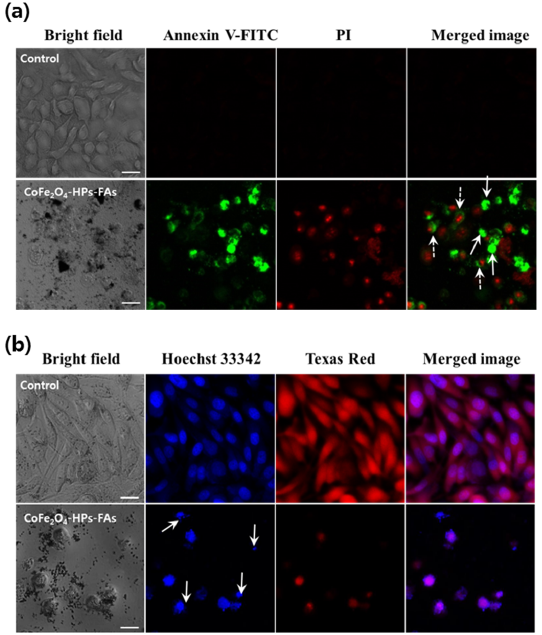
Figure 6. Confocal fluorescence images for cell membrane translocation and nuclear fragmentation in apoptotic PC-3 cells. ( a ) Confocal fluorescence images for cell membrane translocation stained with Annexin V-FITC (green) for the cell membrane and propidium iodide (PI, red) for the nucleus in PC-3 cells at 6 h post-irradiation. Cells stained green are apoptotic cells, and solid line and dashed arrows indicate early- and late-stage apoptotic cells, respectively; ( b ) Confocal fluorescence images for nuclear fragmentation (solid line arrows) stained with Hoechst 33342 (blue) for the nucleus and with Texas Red (red) for whole cells in PC-3 cells at 6 h post-irradiation. Apoptotic cell death was induced by LED irradiation at an irradiation dose of 18.36 J/cm 2 after treatment with 6.25 (0.8) µ g/mL CoFe 2 O 4 -HPs-FAs (HPs) for 2 h. The scale bar represents 25 µ